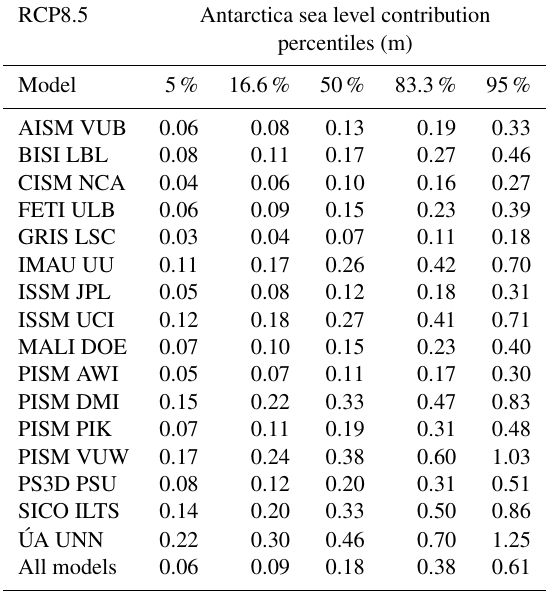
Table 10. Percentiles of the probability distribution of the sea level contribution of Antarctica for different ice sheet models under the RCP8.5 climate scenario. The 50th percentile corresponds to the median; 16.6%–83.3% is the so-called “likely range” as denoted in the IPCC reports. The “very likely range” is given by the 5th–95th percentiles.